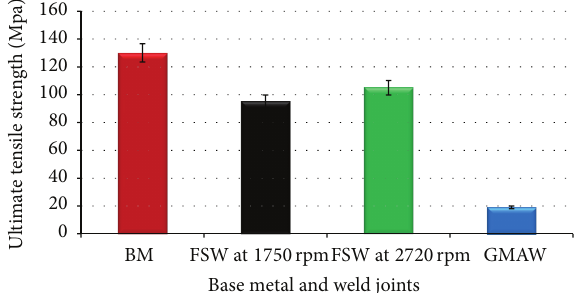
Figure 15: The UTS of the base metal and the weld joints produced by the FSW and the GMAW techniques.